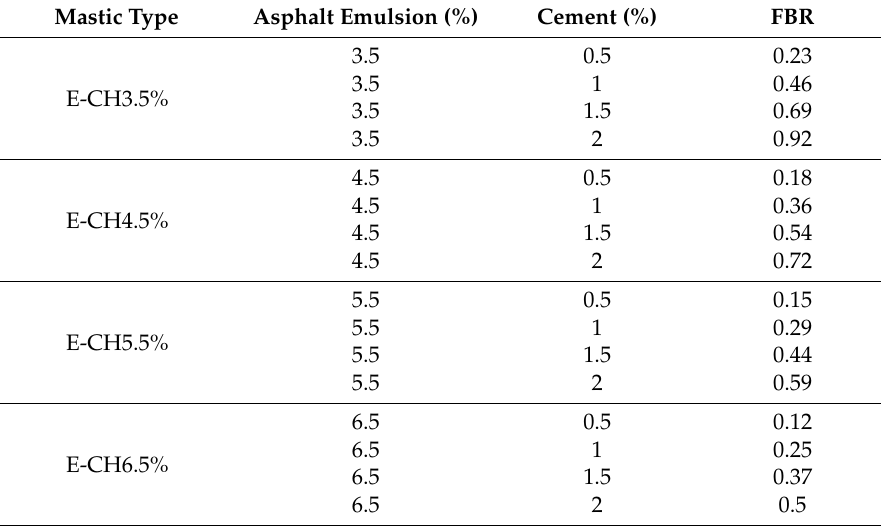
Table 6. Production parameters of cement-residue